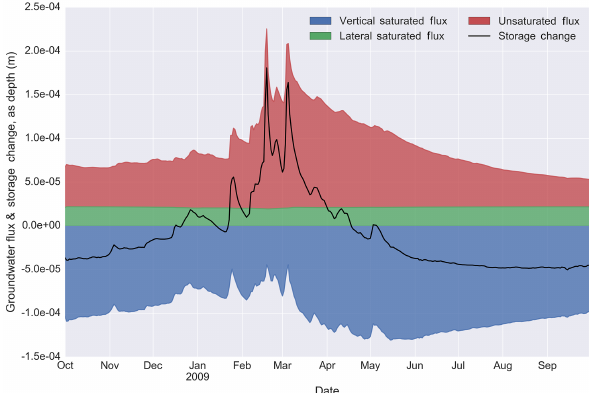
Figure 7. Daily time series of bulk fluxes to/from the simulated Central Valley aquifer system. Positive values indicate a net flow into the aquifer. Negative values indicate net flow out of the aquifer. The balance of inflows and outflows is shown as the change in stor- age (black